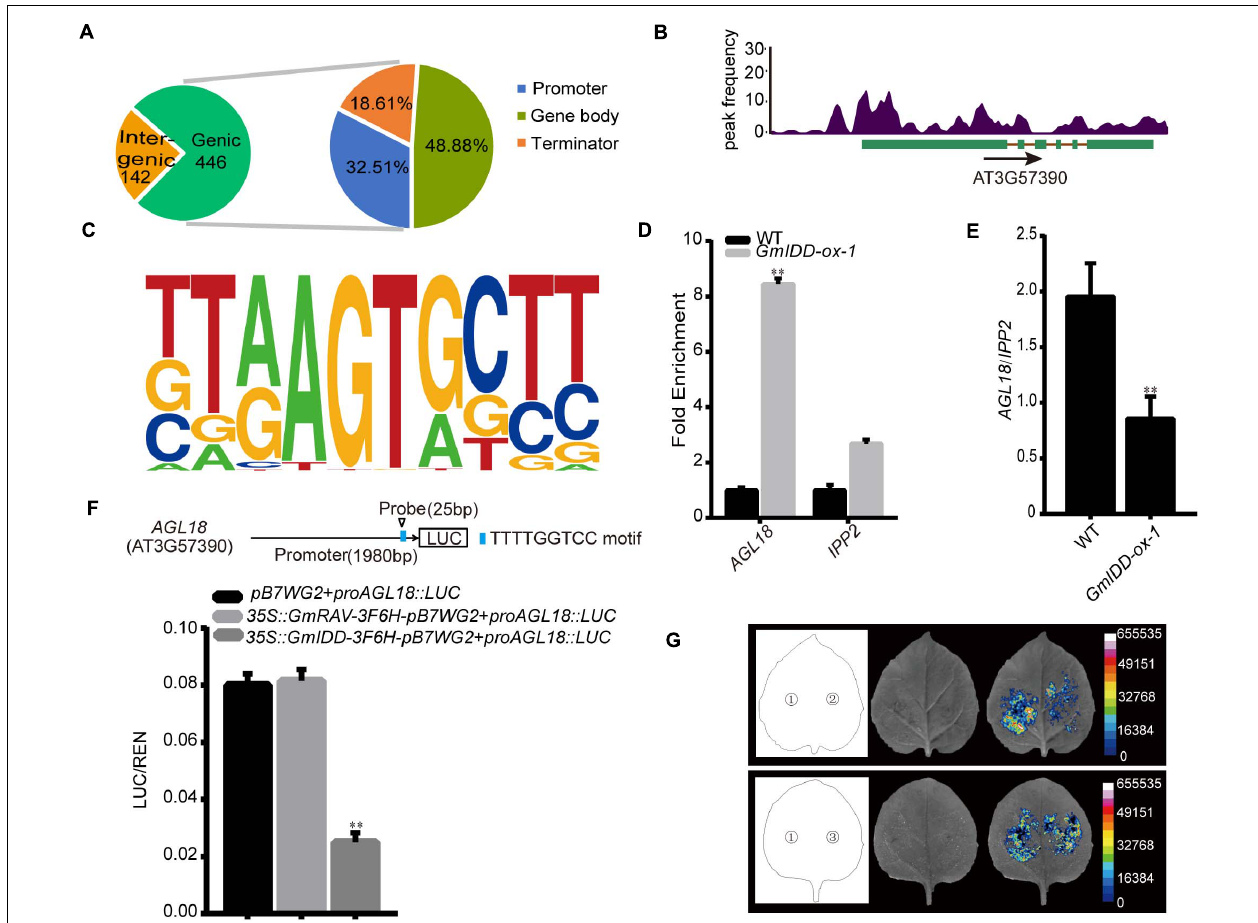
FIGURE 4 | Validation and expression analyses of selected GmIDD target genes. (A) Distribution of the locations of binding sites relative to target genes. Promoter: a sequence within 2 kb upstream of transcription start site; Terminator: the sequence within 2 kb downstream of the transcription termination site; Gene body: 5 (cid:48) UTR, CDS, intron, and 3 (cid:48) UTR. (B) Peak graphs showing the ChIP-seq raw reads at the indicated gene loci in Integrative Genomics Viewer. The arrows indicate the directions of transcription, and the green bars indicate the transcripts of gene. (C) Motif analysis of GmIDD -binding sequences using HOMER software. (D) Anti-Flag antibody was used to precipitate chromatin prepared from GmIDD-ox transgenic Arabidopsis plants. The relative enrichment of the WT fragment was set as 1.0 and those of other fragments were adjusted accordingly. IgG was used as an antibody control. IPP2 was used as the internal gene control. (E) qRT-PCR analysis of the transcript levels of AGL18 in the 14-day-old WT, and GmIDD-ox-1 transgenic Arabidopsis plants. (F) The effect of GmIDD protein on the AGL18 promoter activity. Relative luciferase activity of co-transfected effector and reporter genes in tobacco leaves was detected in LDs. The activities of firefly LUC were normalized by the activities of 35S:Renilla LUC. Results represent means ± SD of eight independent samples ( ∗∗ P < 0.01 vs. no effector, Student t -test). Upper panel: physical locations of fragments harboring putative motifs are shown in the schematic diagram. (G) Luciferase activity of AGL18 under LDs. 1: pB7WG2 + proAGL18:LUC as the blank control; 2: 35S:GmIDD-3F6H-pB7WG2 + proAGL18:LUC ; 3: 35S:GmRAV-3F6H-pB7WG2 + proAGL18:LUC as the negative control; D-luciferin was used as the substrate of LUC. For each experiment, three technical replicates were conducted. Data shown are mean ± SD of three independent experiments ( ∗∗ P < 0.01, Student’s t